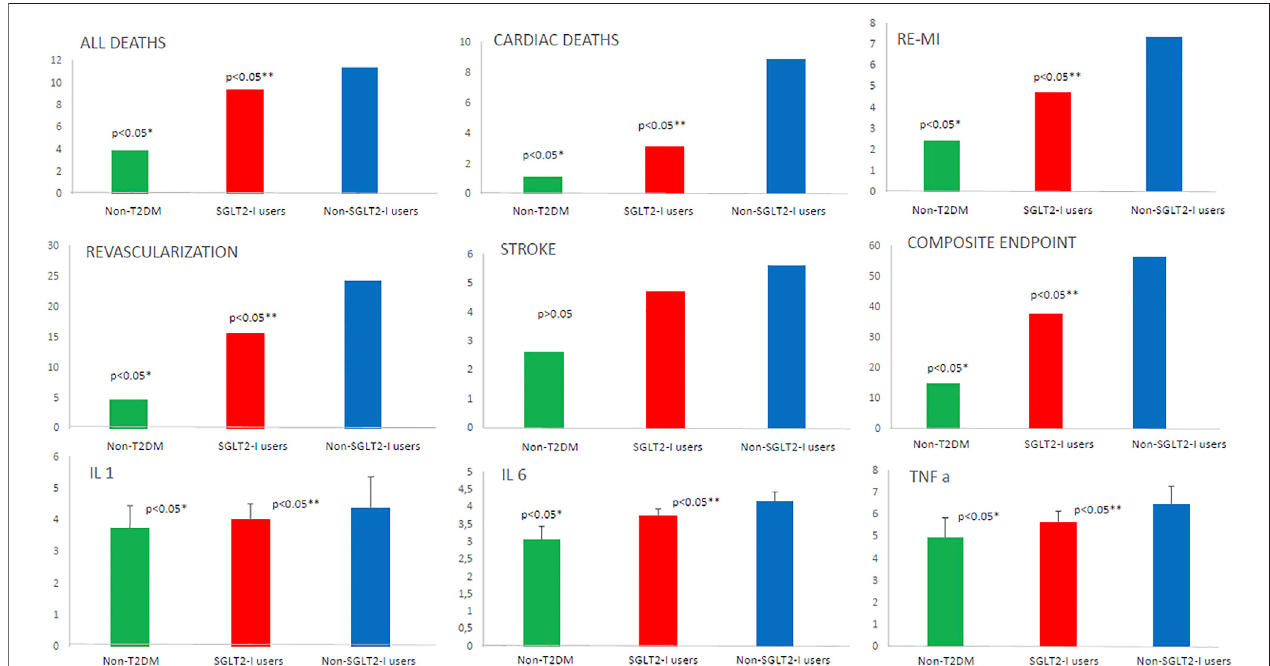
FIGURE 2 | The representation of the study outcomes at 5 years of follow-up in patients without type 2 diabetes mellitus (non-T2DM; green color) vs T2DM under sodium-glucose transporter 2 inhibitors (SLGT2-I users; red color) vs T2DM patients without sodium-glucose transporter 2 inhibitors (non-SLGT2-I users; blue color). We reportedthepercentage ofeventsforalldeaths,cardiac deaths,re-myocardialinfarction(re-MI),stroke, revascularization,andcomposite endpoint.Forinterleukin 1 (IL-1),interleukin6(IL-6),andtumornecrosisfactor-alpha(TNF- α ),weusedthevaluesasmean ± standarddeviation.*Isforstatisticalsigni fi cant( p -value < 0.05)vs T2DM; ** is for statistical signi fi cant ( p value < 0.05) comparing SGLT2-I users vs non – SLGT2-I users.